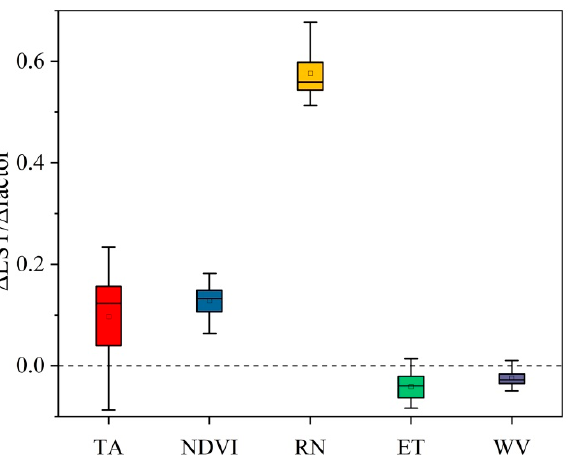
Figure 6. ECCM detection between LST and environmental factors for the pixel selected from PMC region ( a ) TA causing LST; ( b ) NDVI causing LST; ( c ) RN causing LST; ( d ) ET causing LST; ( e ) WV causing LST.